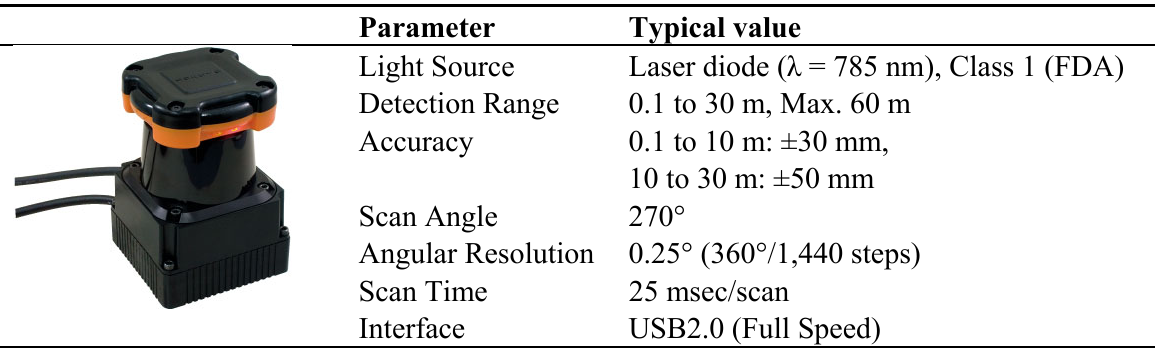
Table 4. Hokuyo UTM-30LX